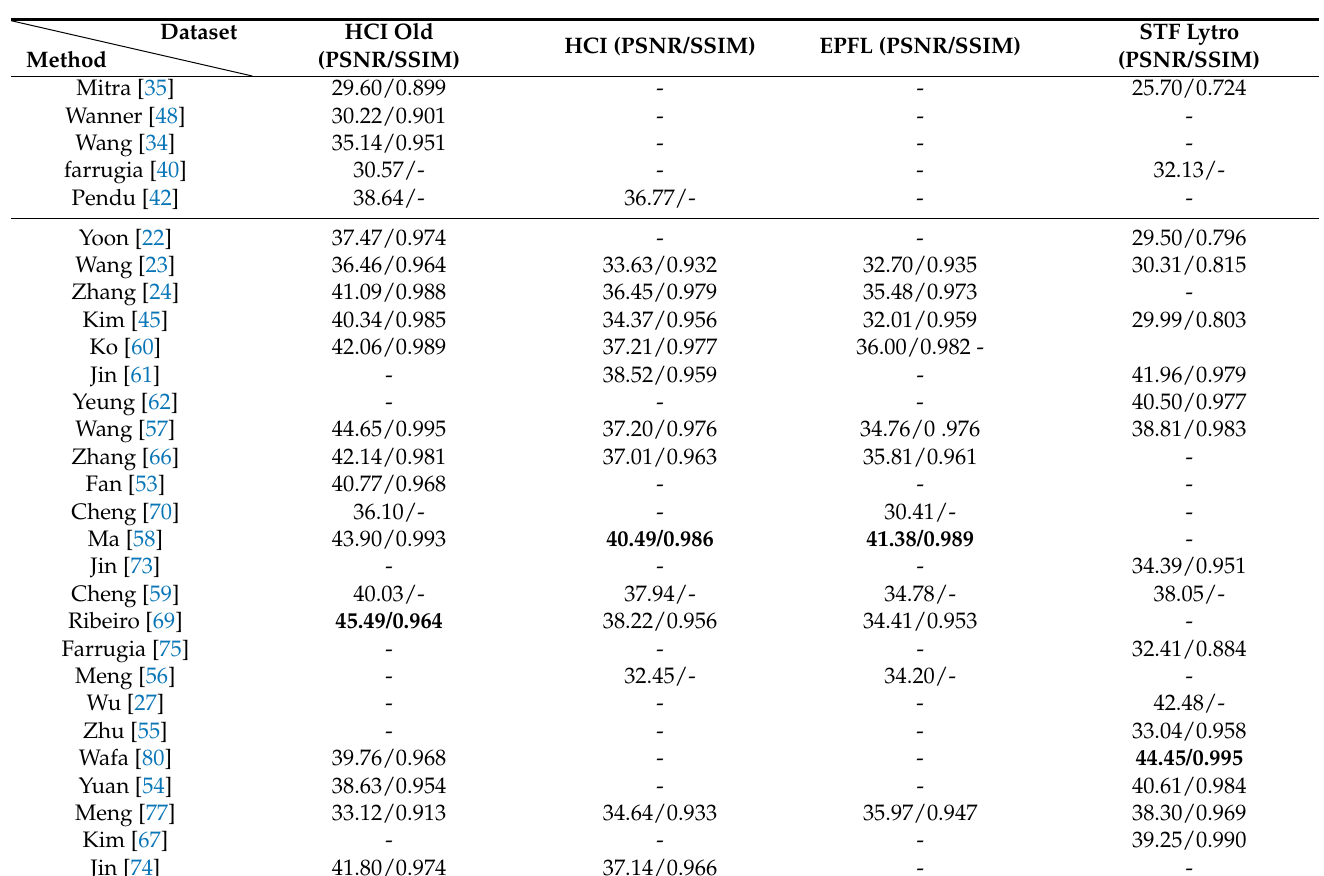
Table 4. Performance comparison of light field super-resolution algorithms, where best results are in bold and “-” means not tested. The five methods above are traditional methods, while others are deep learning based